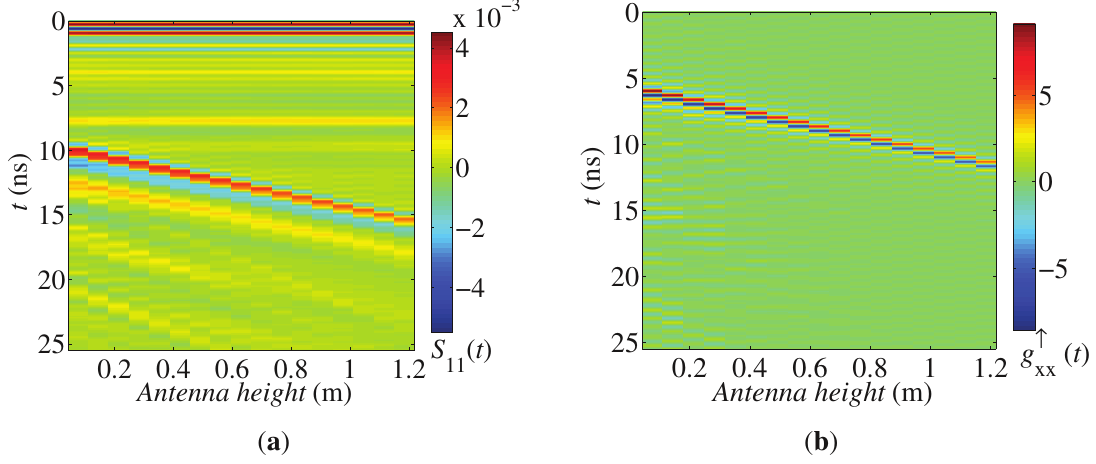
Figure 4. Time domain representation (b-scan) of radar measurement performed with the horn antenna at different heights above a perfect electrical conductor (copper sheet). ( a ) Measured raw GPR signal S 11 ( t ) and ( b ) the filtered signal g ↑